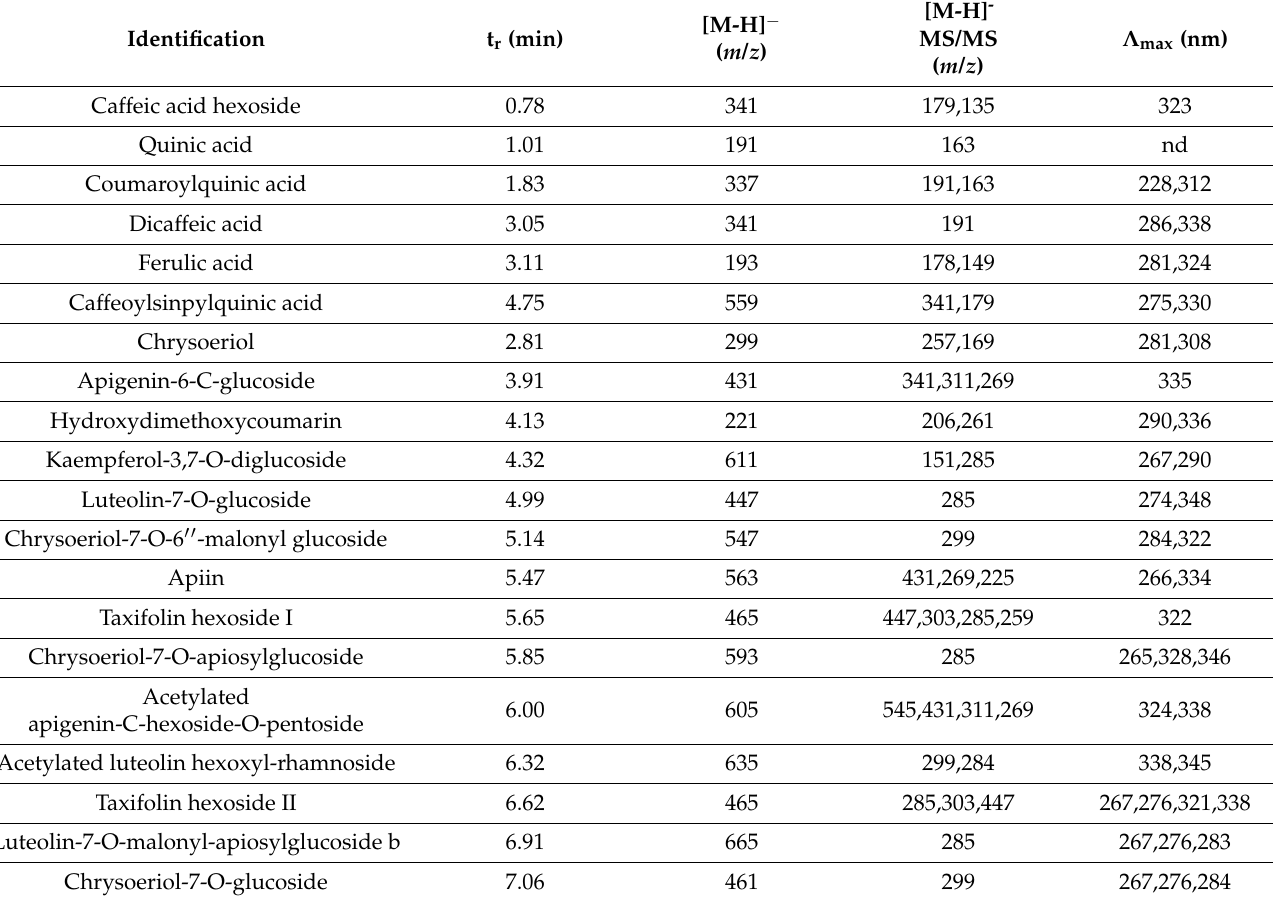
Table 3. Identification of phenolic compounds in celeriac